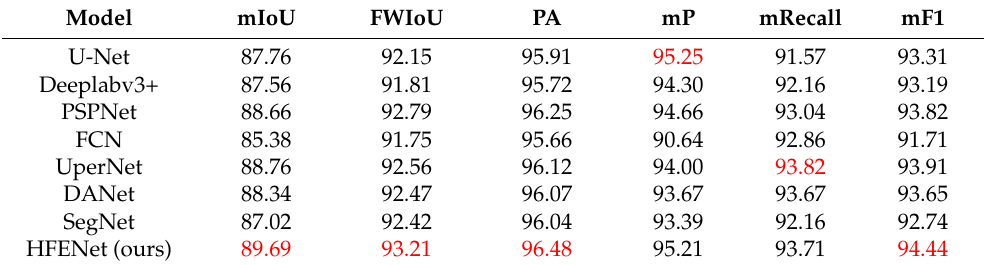
Table 7. Quantitative results of the state-of-the-art models on the landcover.ai (%).